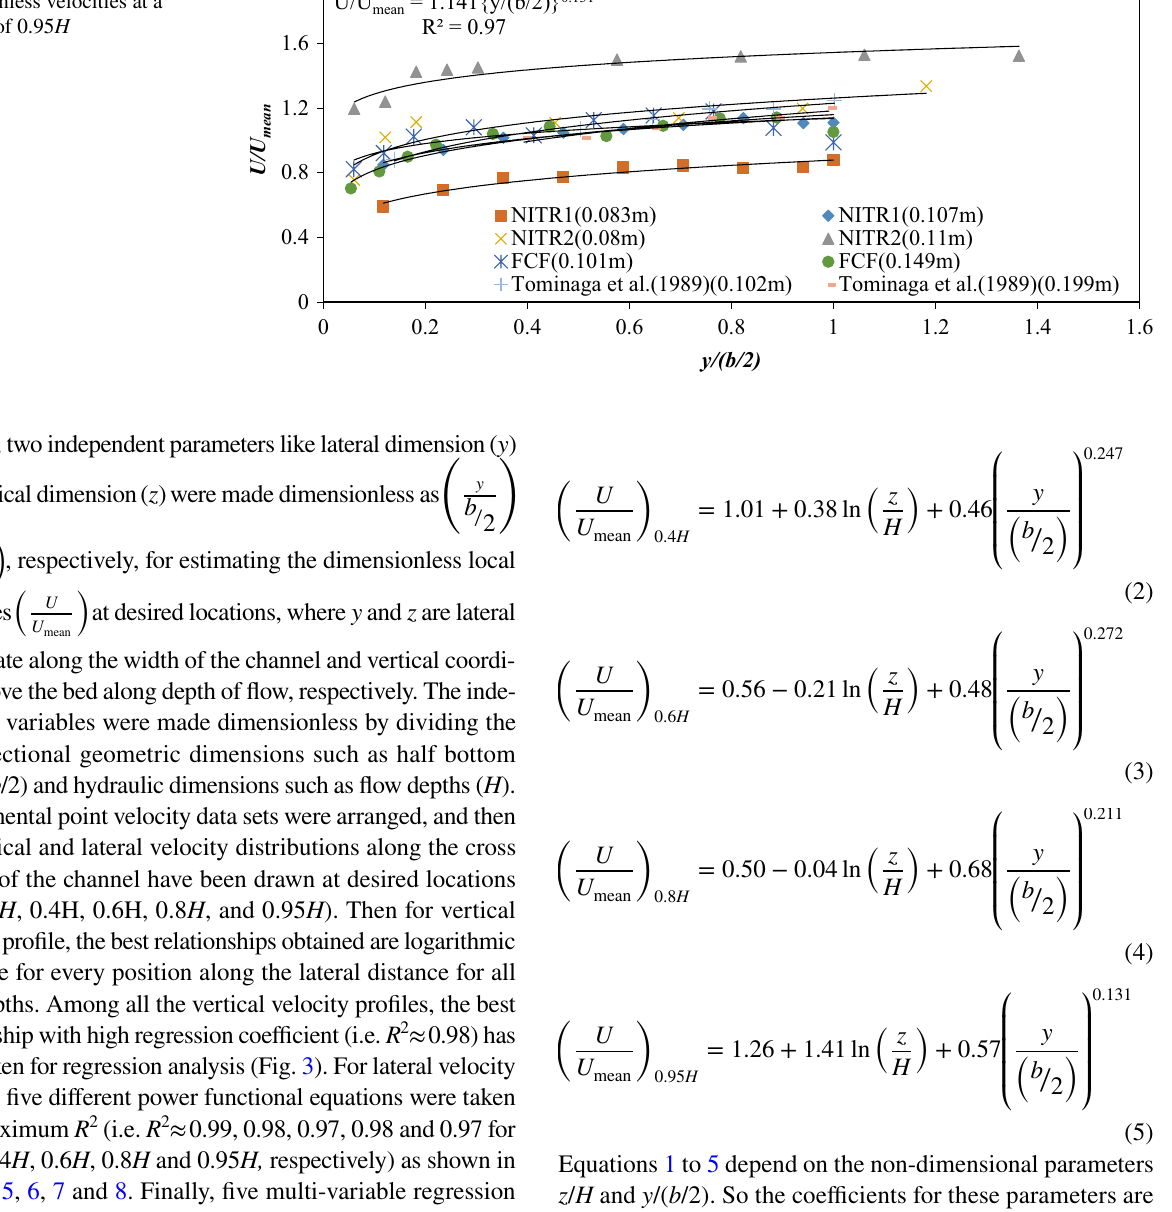
U/U = 1.141{y/(b/2)} 0.131 mean R² =